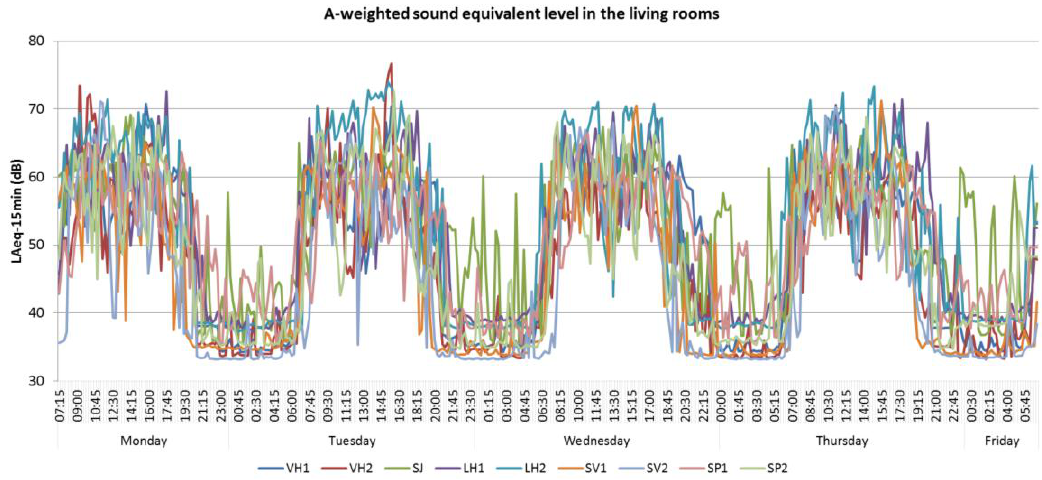
Figure 3. Equivalent sound level patterns in the living rooms during the monitoring week.